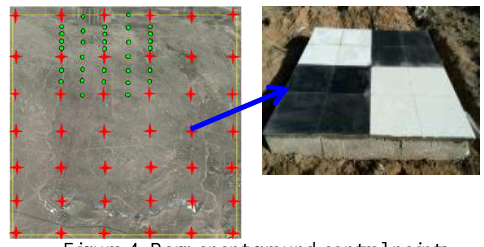
Figure 4. Permanent ground control